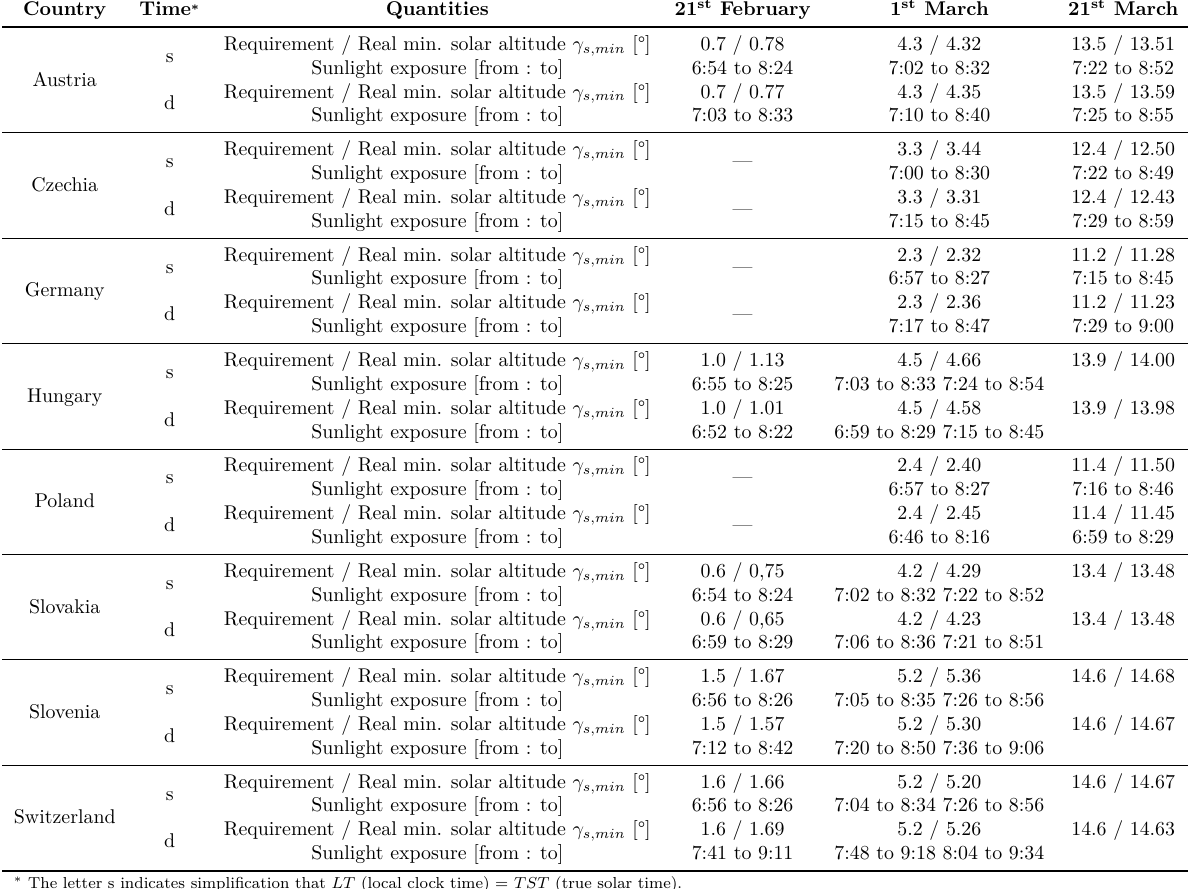
Table 3. Sunlight exposure (total sunlight exposure is min. 1.5 hours in all